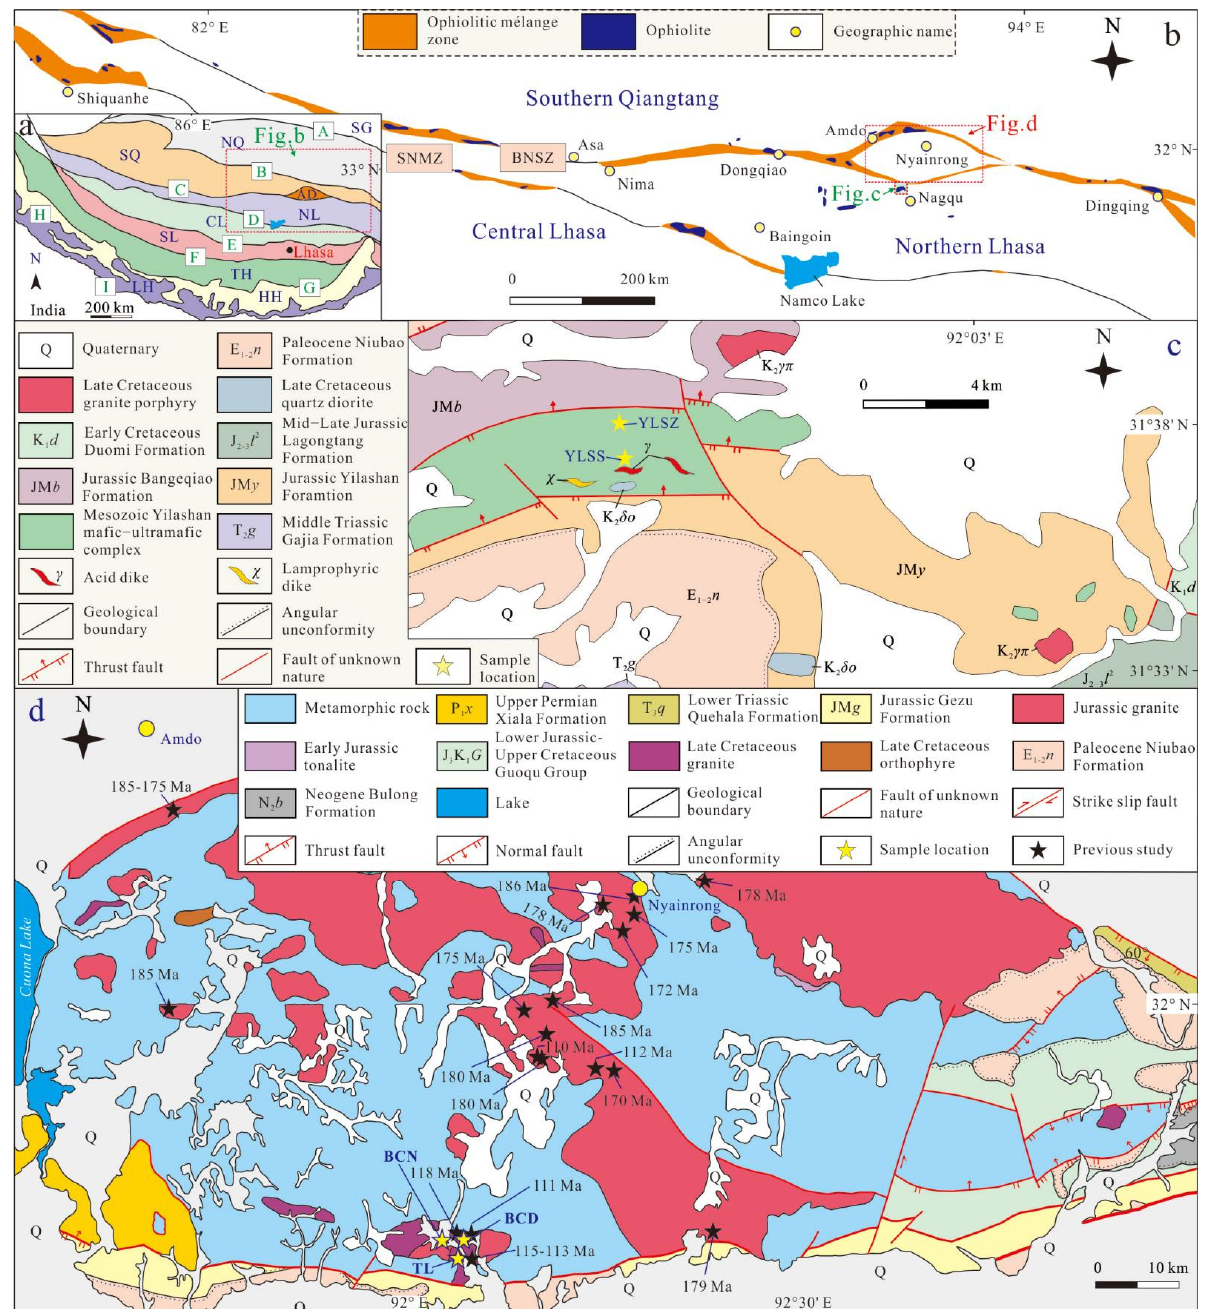
Figure 1. Inset showing the location of Figure 1b in the Tibetan Plateau ( a ) [9]. SG: Songpan–Ganzi terrane; NQ: Northern Qiangtang terrane; SQ: Southern Qiangtang terrane; AD: Amdo terrane; NL: Northern Lhasa terrane; CL: Central Lhasa terrane; SL: Southern Lhasa terrane; TH: Tethyan Himalaya terrane; HH: High Himalaya terrane; LH: Lesser Himalaya terrane. A: Jinsha suture zone; B: Longmuco–Shuanghu suture zone; C: Bangong–Nujiang suture zone; D: Shiquanhe–Namco mélange zone; E: Luobadui–Milashan fault; F: Yarlung Zangbo suture zone; G: South Tibetan detachment system; H: Main boundary trust; I: Main boundary trust. Tectonic outline of the Tibetan Plateau and the sketch structural framework of the Lhasa–southern Qiangtang terranes showing the Bangong–Nujiang suture zone ( b ) [9]. Geological sketch maps of the Yilashan ophiolite ( c ) [33] and the Amdo terrane ( d ) [33,34] showing sample localities.